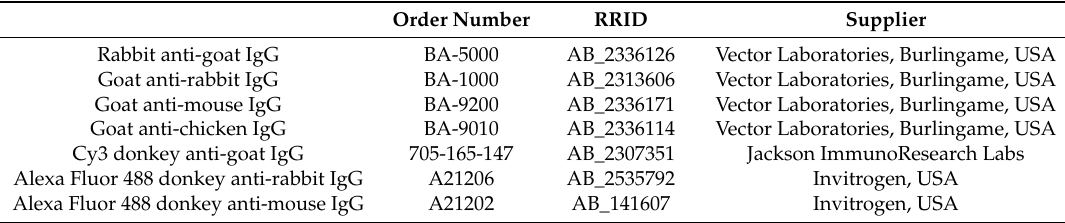
Table 3. List of the secondary antibodies used in this